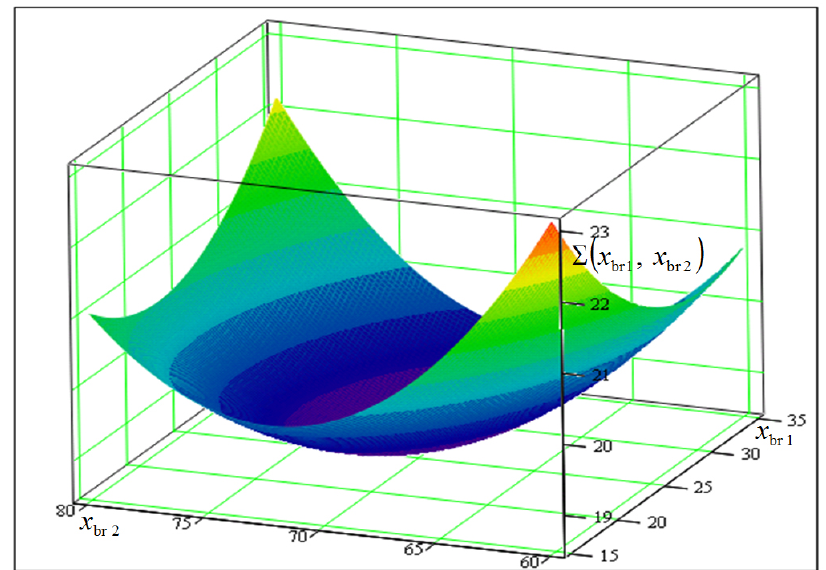
Figure 3. General paraboloid (4) for presented example.